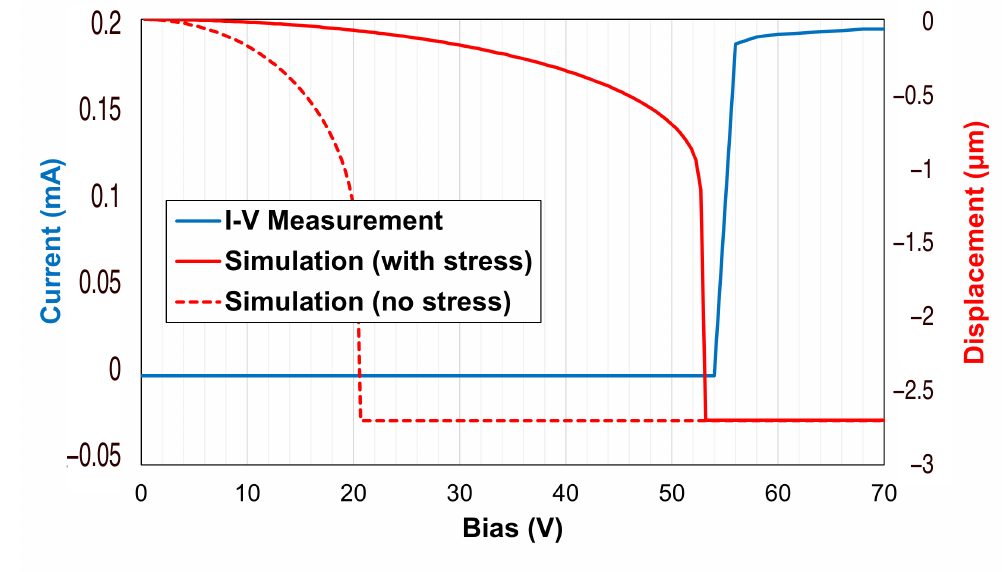
Figure 6. Comparison between the simulated and the measured electromechanical performance of the discussed RF-MEMS